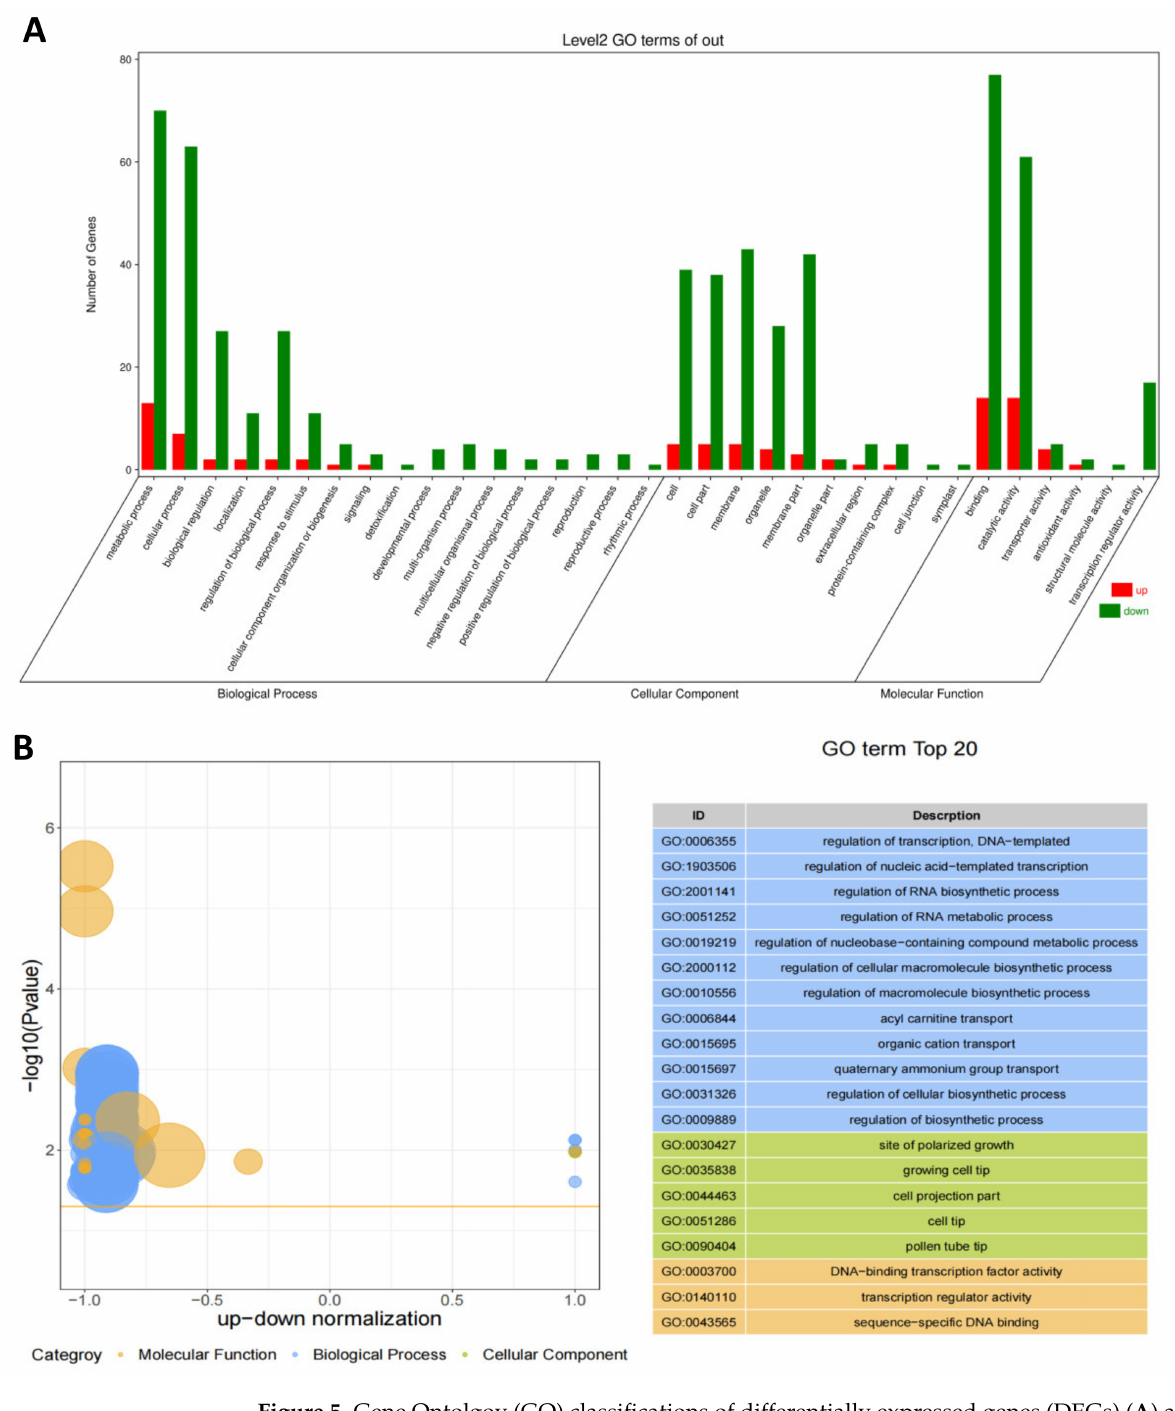
Figure 5. Gene Ontolgoy (GO) classifications of differentially expressed genes (DEGs) ( A ) and the Z-score bubble chart of GO enrichment analysis ( B ) in B-FA99 and D-FA99 during the tetrad stage. The ordinate is -log10 ( p value), the abscissa is the up–down normalization value (the ratio of the difference between the number of differentially upregulated genes and the number of differentially downregulated genes to the total differential genes). The bubble size indicates the number of target genes enriched by the current GO term; the yellow line represents the threshold of p value = 0.05; the right side is the list of terms with the top 20 p values, and different colors represent different